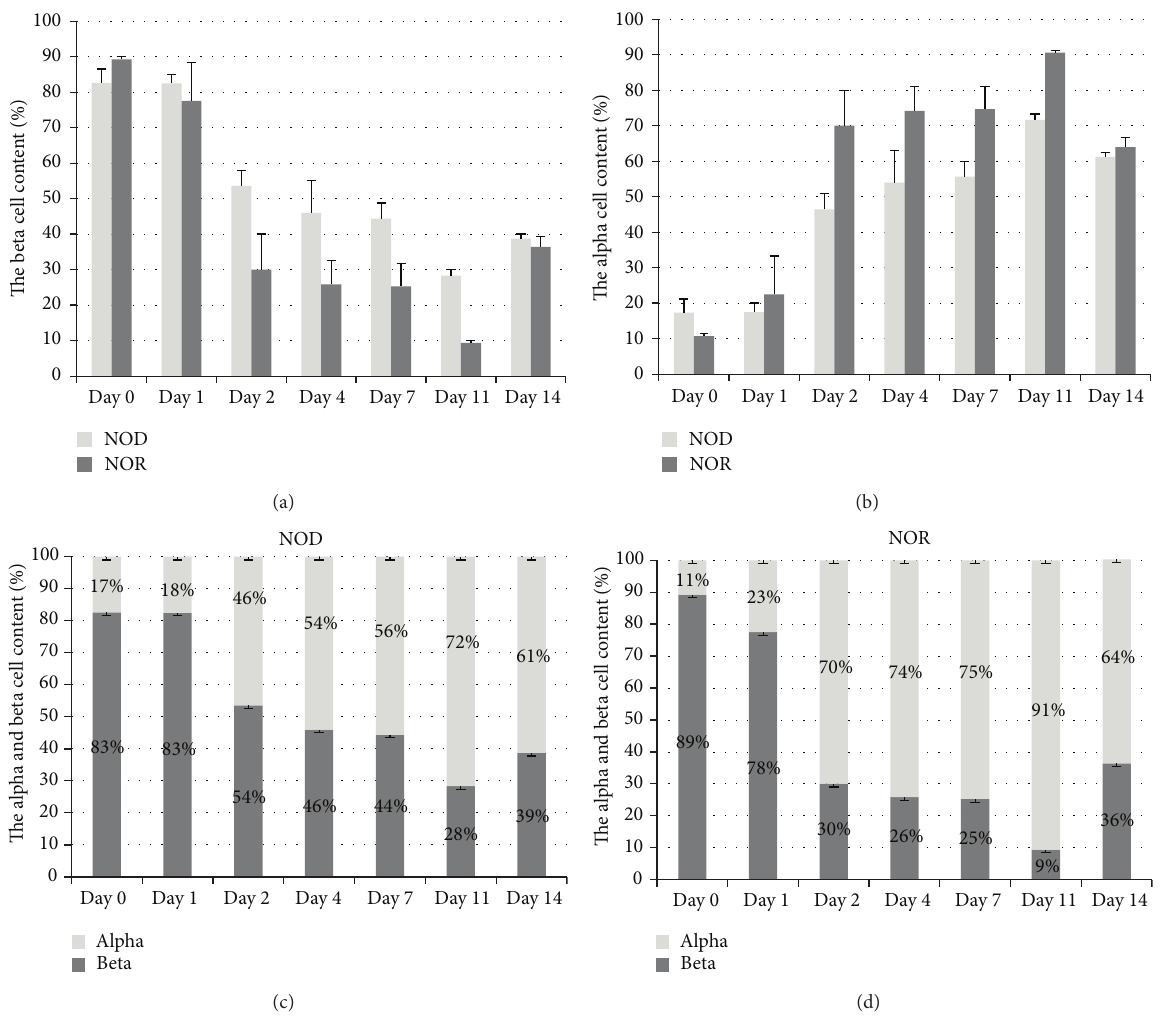
Figure 2: Quantitative analysis of alpha and beta cell contents in pancreatic islets of NOD and NOR mice following STZ injection. Upper panel displays changes in beta (a) and alpha (b) cell percentages within the islets compared in NOD (lighter bars) and NOR mice (darker bars). In the lower panel, progressive alterations in comparative proportions of alpha and beta cell contents are shown in NOD (c) and in NOR mice (d). ∗ 𝑃 < 0.05 , NOD versus NOR (Student’s 𝑡 -test). Error bars represent ± SEM ( 𝑛 = 3 for each time